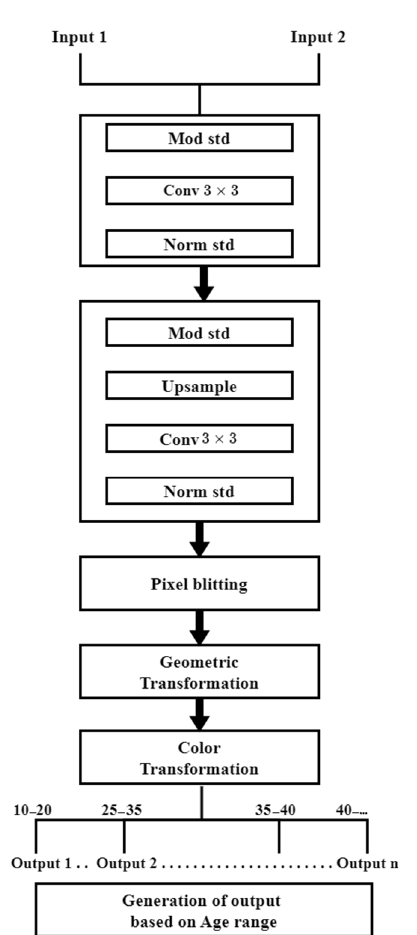
Figure 1. Overview of the proposed FLM method.